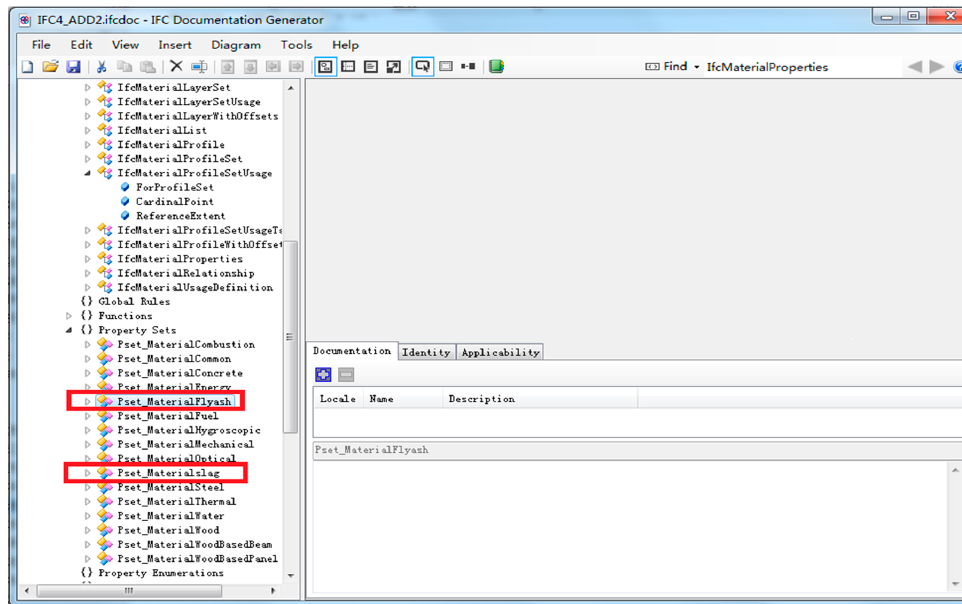
Figure 15. Insert the new properties in IFC.